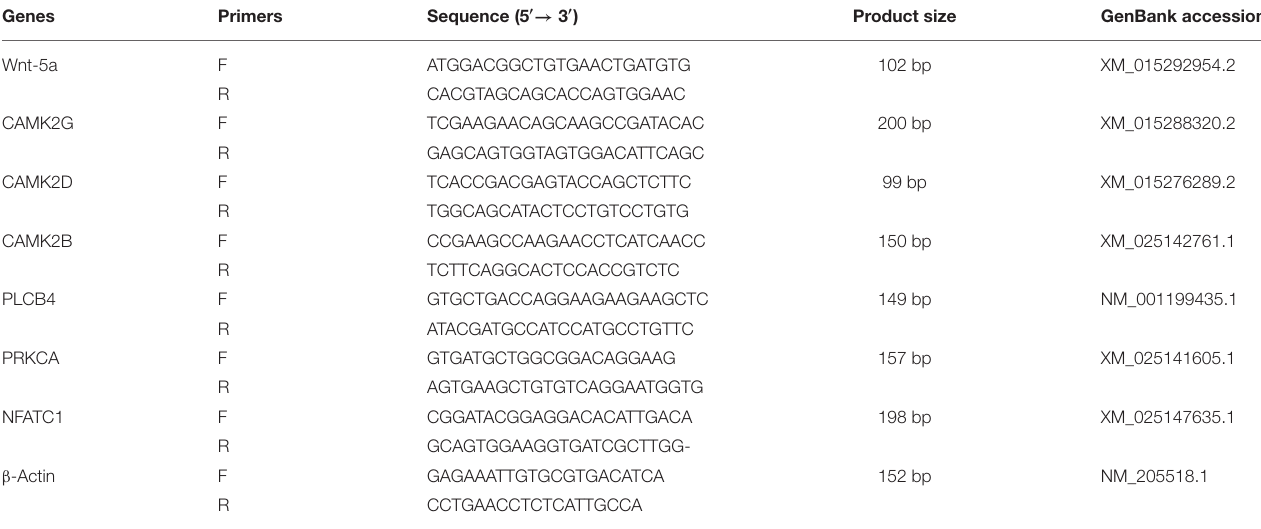
TABLE 2 | Primers of genes used for mRNA expression level.